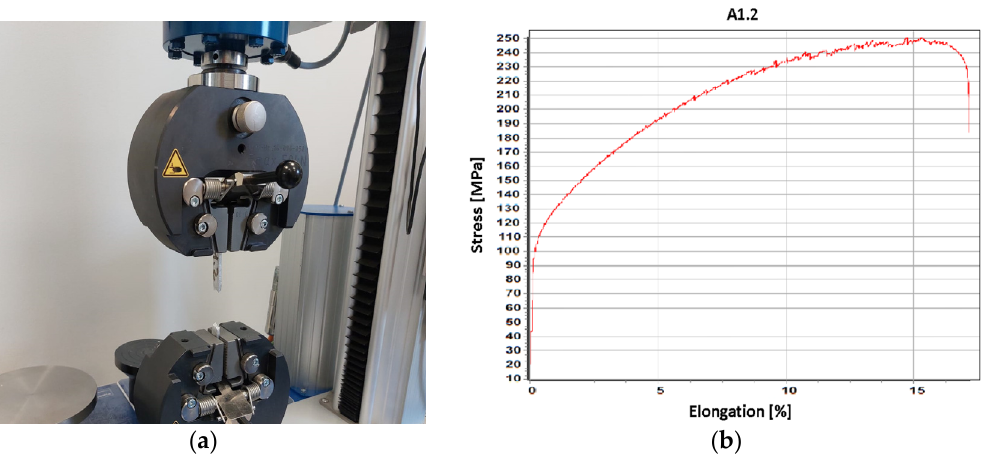
Figure 5. ( a ) Tensile test on Hegenwald&Perschke Universal Machine ( b ) Stress-Elongation graph of the A1.2 specimen.